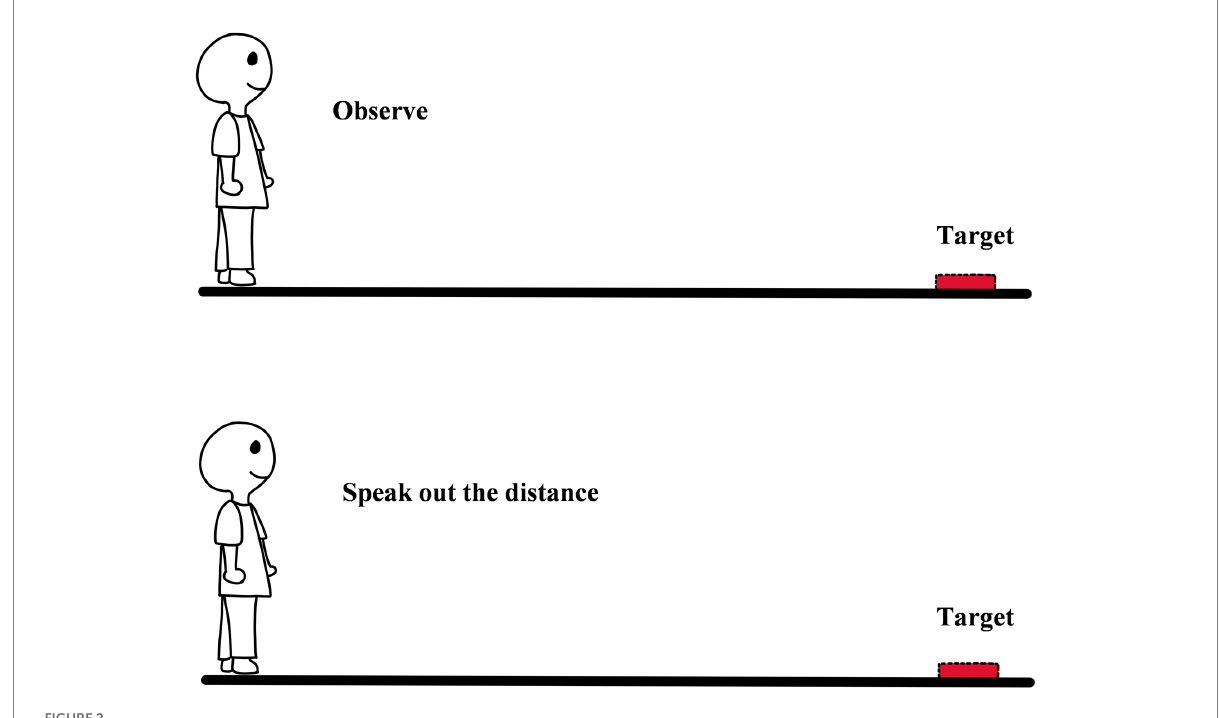
FIGURE 2 The diagram of verbal reporting.